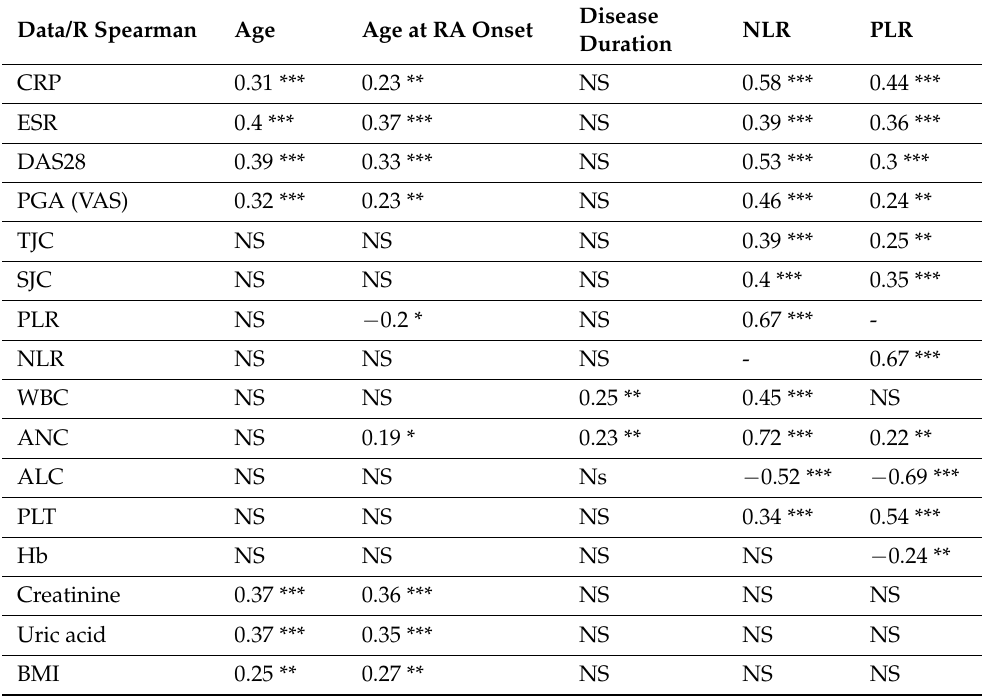
Table 3. Associations with timewise and hematological systemic inflammatory parameters in 113 RA